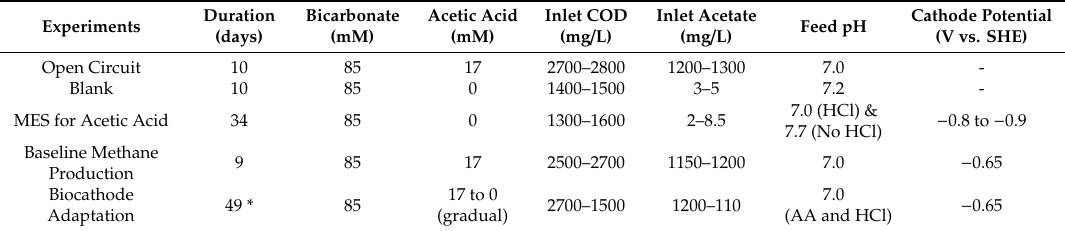
Table 1. Experimental and feed conditions used in the current